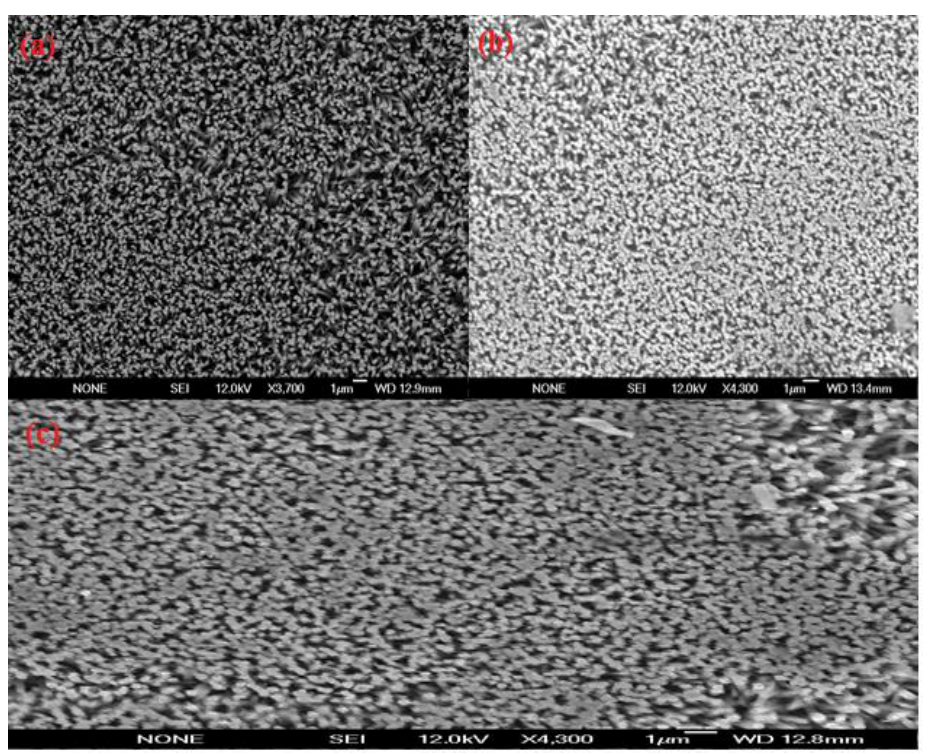
Figure 1. ( a–c ) Field emission scanning electron microscopy (FESEM) images of the ZnO nanorods grown on gold coated glass substrate using the aqueous chemical